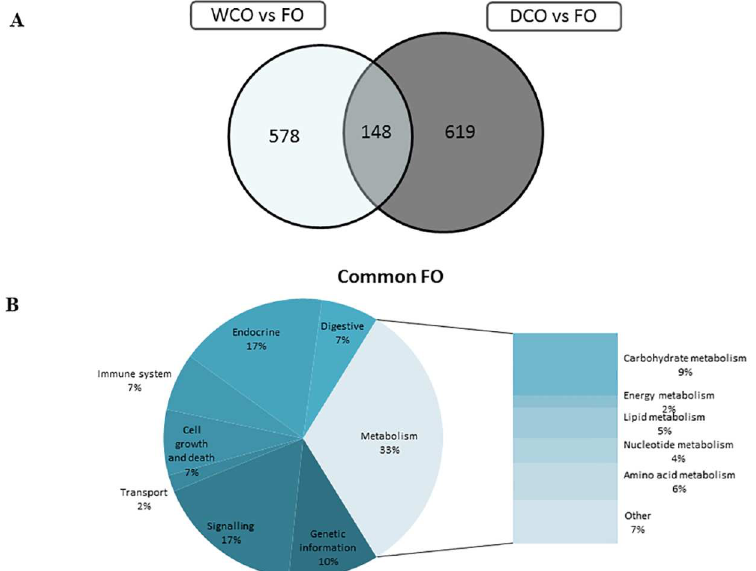
Fig 1. Impact of diet on midgut transcriptome of Atlantic salmon fed camelina oils (DCO and WCO) in comparison with fish fed Fish Oil (FO). (A) Venn diagram representing mRNA transcripts differentially expressedin the midgut of Atlantic salmon fed the experimental diets DCO and WCO compared to diet FO. The area of the circles is scaled to the numberof transcripts (Welch t-test; p < 0.05; FC > 1.3). (B) Distributionby categoriesof common differentiallygenes in midgut betweenAtlantic salmon fed DCO and WCO when comparedto FO-fed fish (Welch t-test; p < 0.05; FC > 1.3). Non-annotated genesand features corresponding to the same gene are not